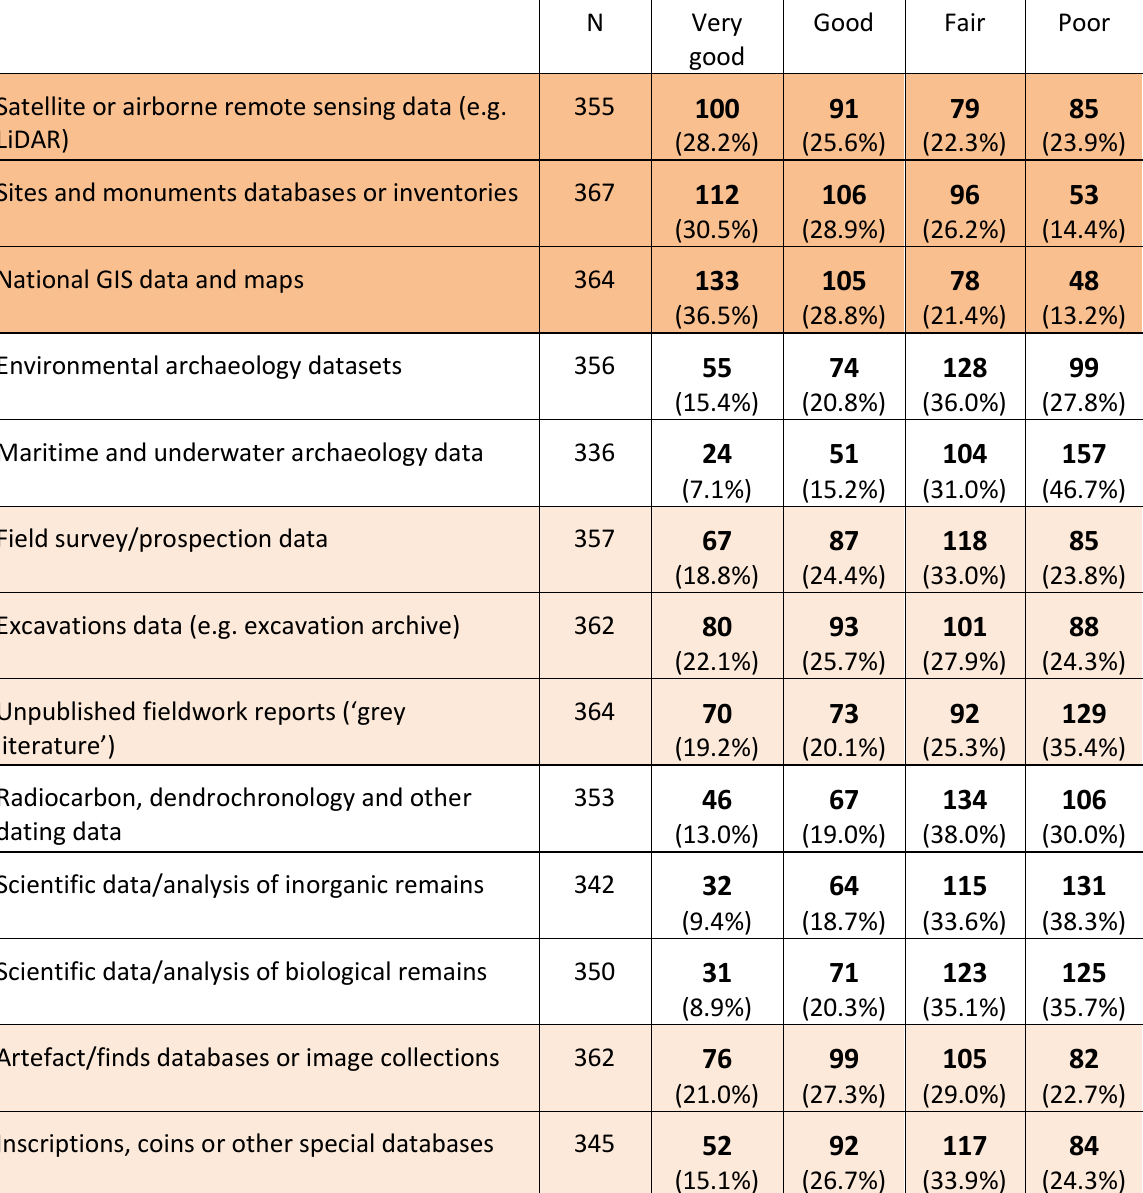
Table 16.2 : Rating of the online accessibility of different types of data (N =